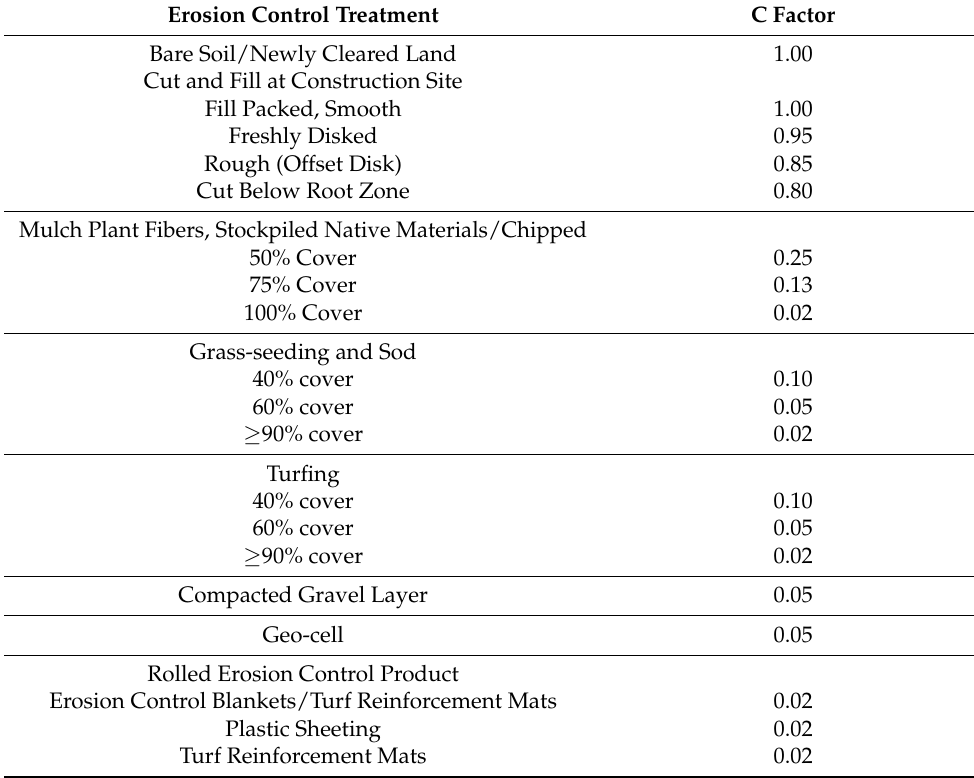
Table 4. Cover management, C factor, for BMPs at construction sites 1